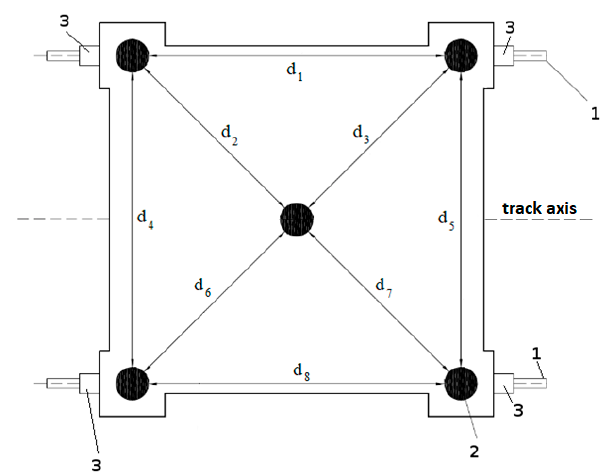
Figure 2. The diagram of the MMP: 1—rails, 2—points of forced centring of a Global Navigation Satellite System (GNSS) receiver, 3—platform wheels, d i —distances between the GNSS centring points.